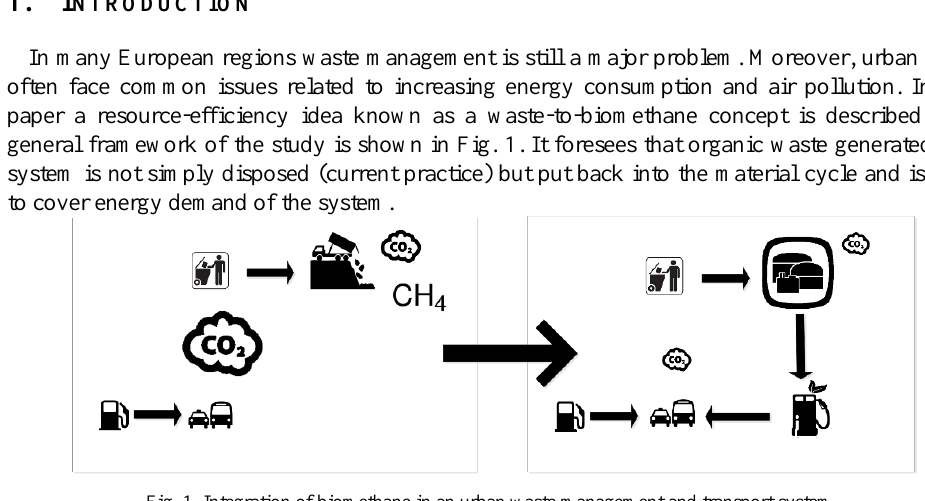
Fig. 1. Integration of biomethane in an urban waste management and transport